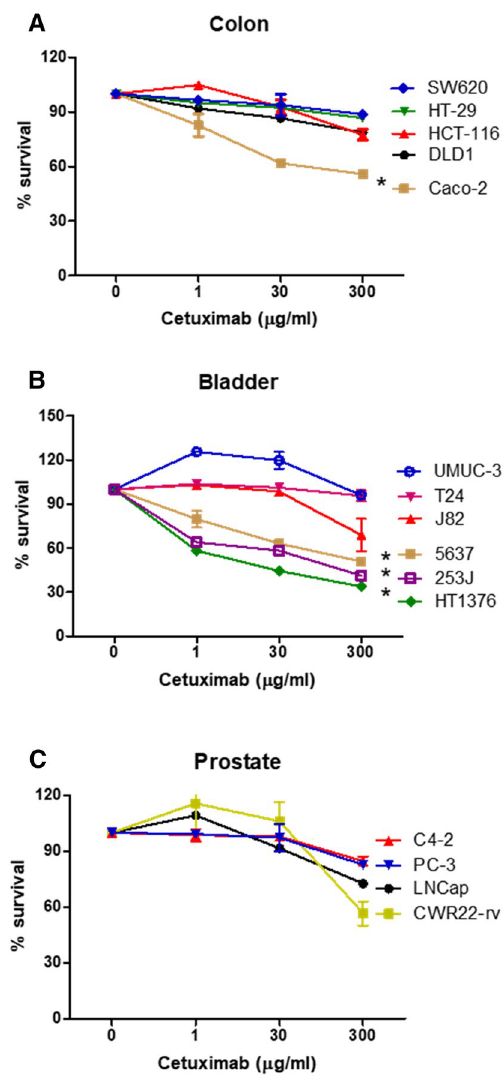
Figure 1. Effects of cetuximab on the colon, bladder, and prostate cancer cells. Cetuximab-mediated cancer cell killing was performed using the MTT cell proliferation assay. Cancer cells from colon ( A ), bladder ( B ), or prostate ( C ) were treated with cetuximab at concentrations ranging from 0 to 300 μg/ml for 72 h. The cells were stained with the MTT reagent, and the absorbance was measured at 570 nm. Experiments were repeated three times. The * in the diagram, determined with Turkey’s studentized range test, corresponds to statistically significant subgrouping of two groups ( p < 0.05). Uppercase wt or m denotes retention of wild type or mutation of corresponding genes: SW620 (KRAS m ), HT-29 (BRAF m /PIK3CA m ), HCT-116 (KRAS m /PIK3CA m ), DLD1 (KRAS m /PIK3CA m ), Caco-2 (KRAS wt /BRAF wt /PIK3CA wt ), UMUC-3 (KRAS m ), T24 (HRAS m ), J82 (PIK3CA m ), 253J (PIK3CA m ), 5637/HT1376 (not known mutations in EGFR signaling), CWR22-rv (PIK3CA m